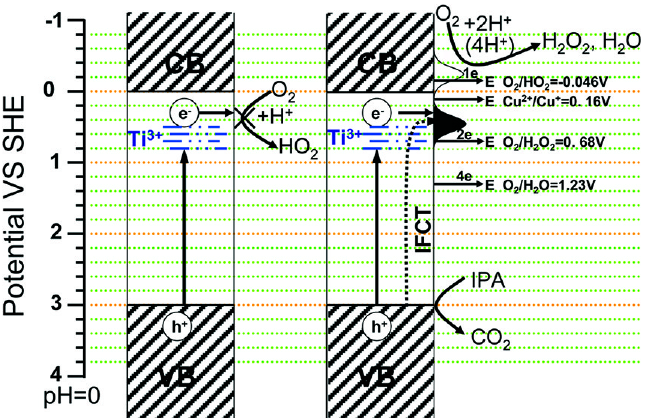
Figure 9. Proposed photocatalytic mechanism of CuO/Ti 3+ ‐ TiO 2 visible light activation. Reprinted with permission from [92]. Copyright American Chemical Society, 2011.